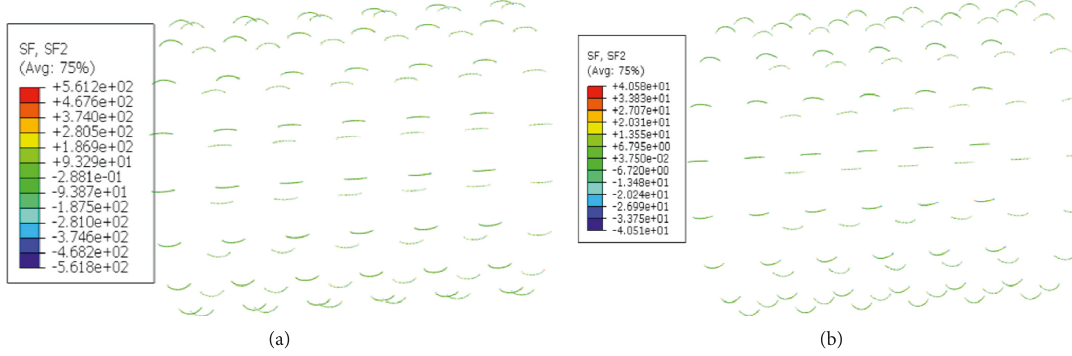
Figure 18: Shear diagram of bolt. Water head difference of (a) 18 m and (b) 0 m.